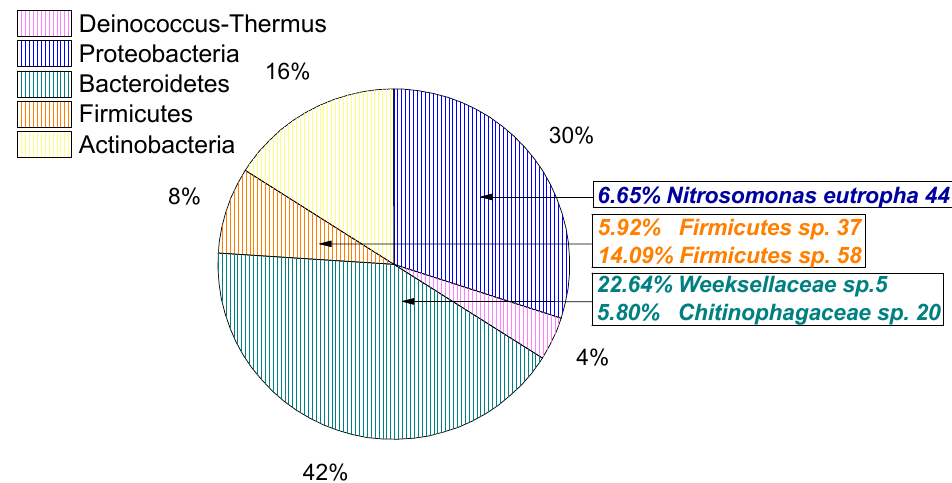
Figure 1. Taxonomic composition of the enriched inoculum bacterial community at phylum levels (the percentages refer to the distribution of the detected bacteria to the relevant phyla) and an indication of the most abundant microorganisms (in terms of the total microbiome).